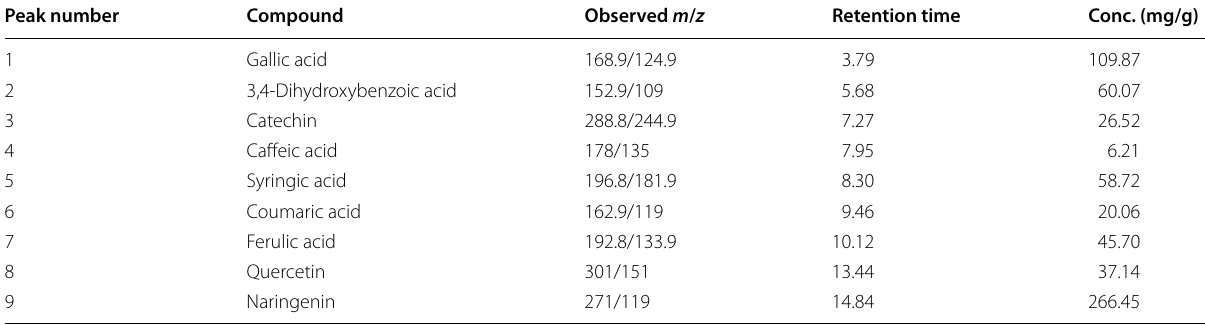
Table 1 Quantitative results for flavonoids and phenolic acids of gentian by HPLC–MS/MS Peak number Compound Observed m /